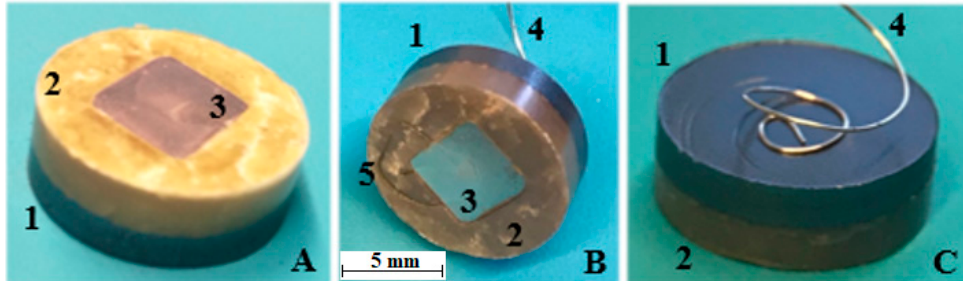
Figure 4. The sandwich structured galvanic cell (( A )—freshly prepared, and ( B , C )—after the meas- urement): 1—the test electrode (three phase mixture), 2—the solid electrolyte (RbAg 4 I 5 ), 3—the ref-